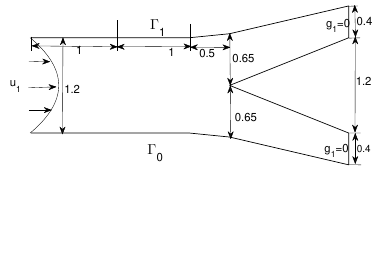
Figure 7. Domain Ω of the blood